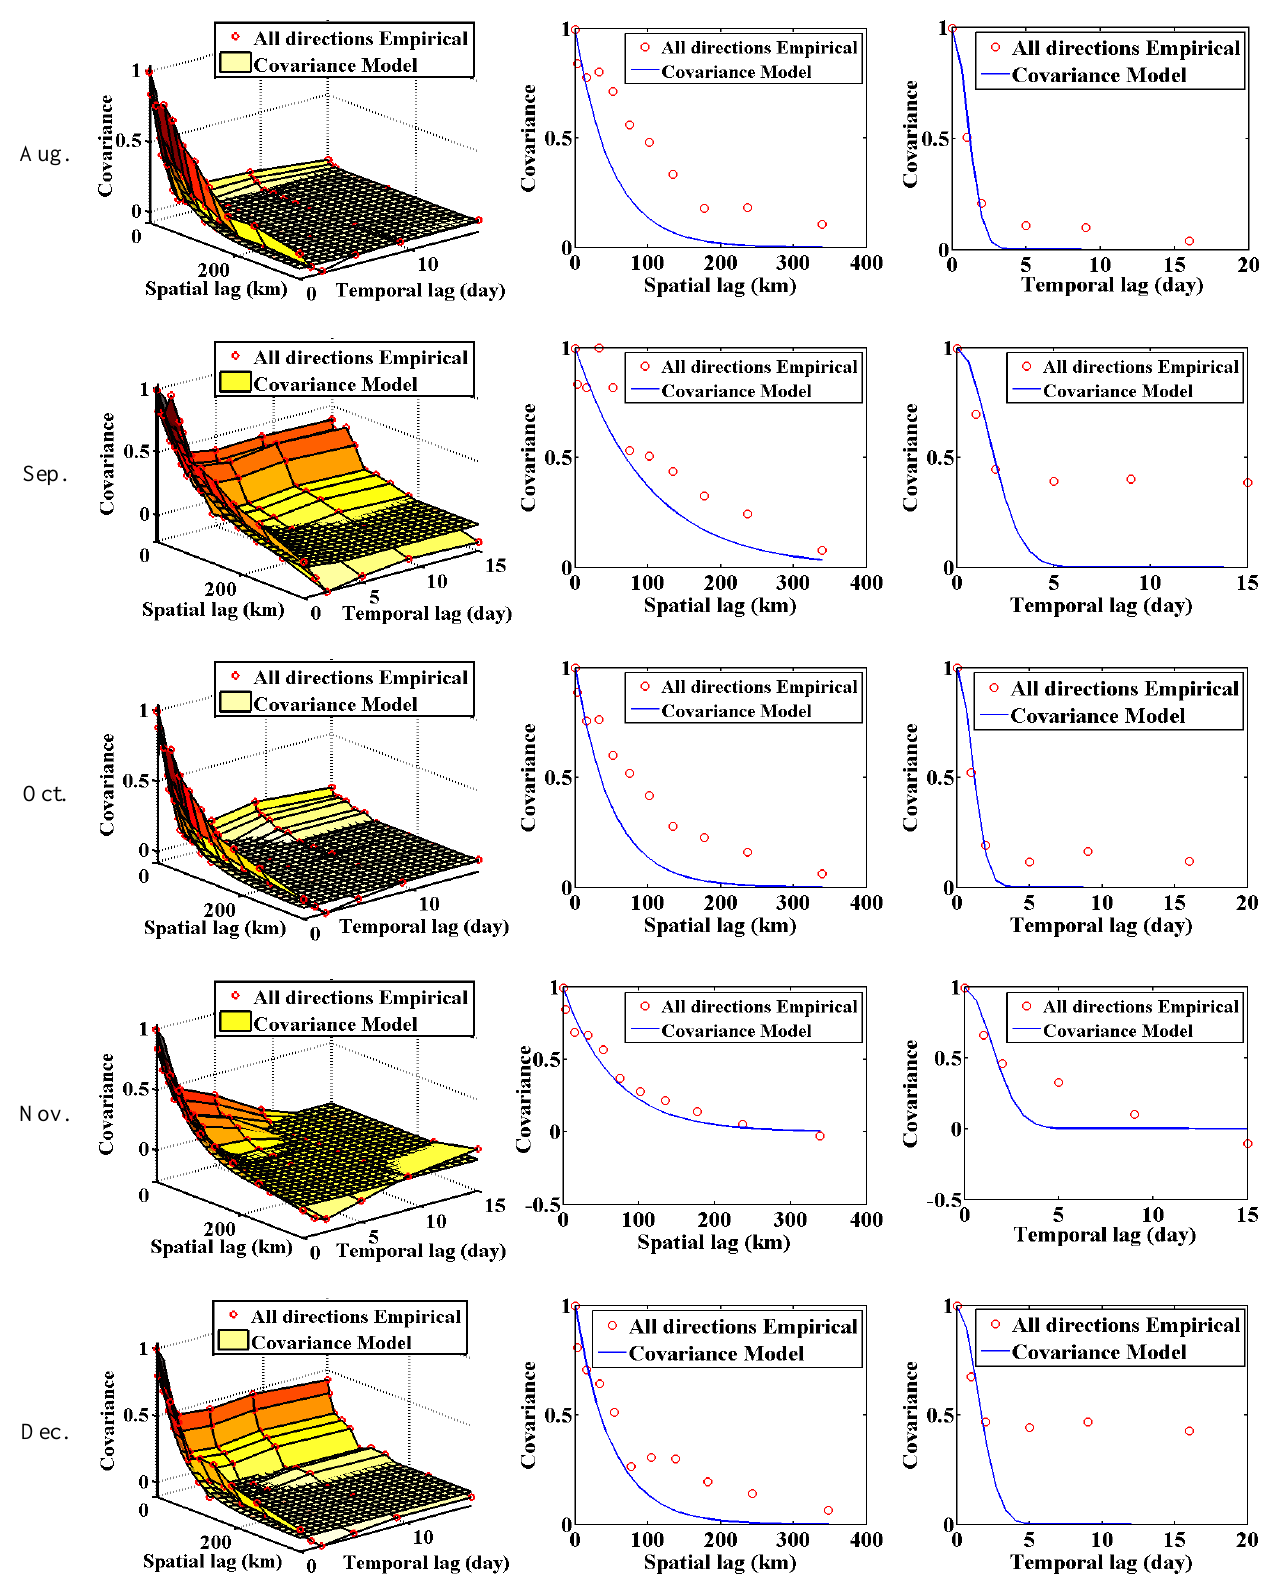
Figure 4. Observed (red circles) and modeled covariance of the O 3 residual concentrations on a daily time scale shown as a function of spatial lag and temporal lag in BME, which showed the spatio-temporal empirical covariance and the fitted model of each month from January to December,